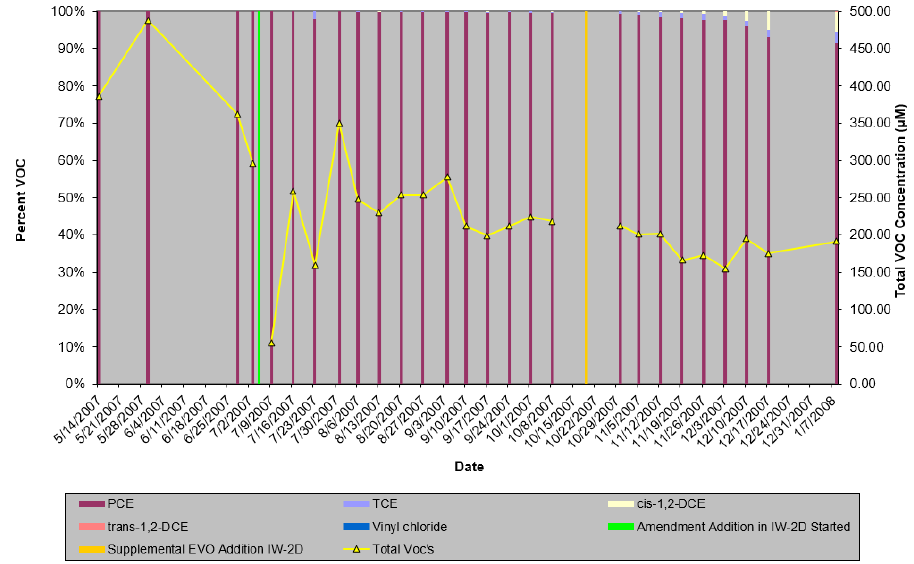
Figure 11. Comprehensive test cell data summary: EVO + hydrogen gas, SMW-3D% VOC, and total VOC concentration.